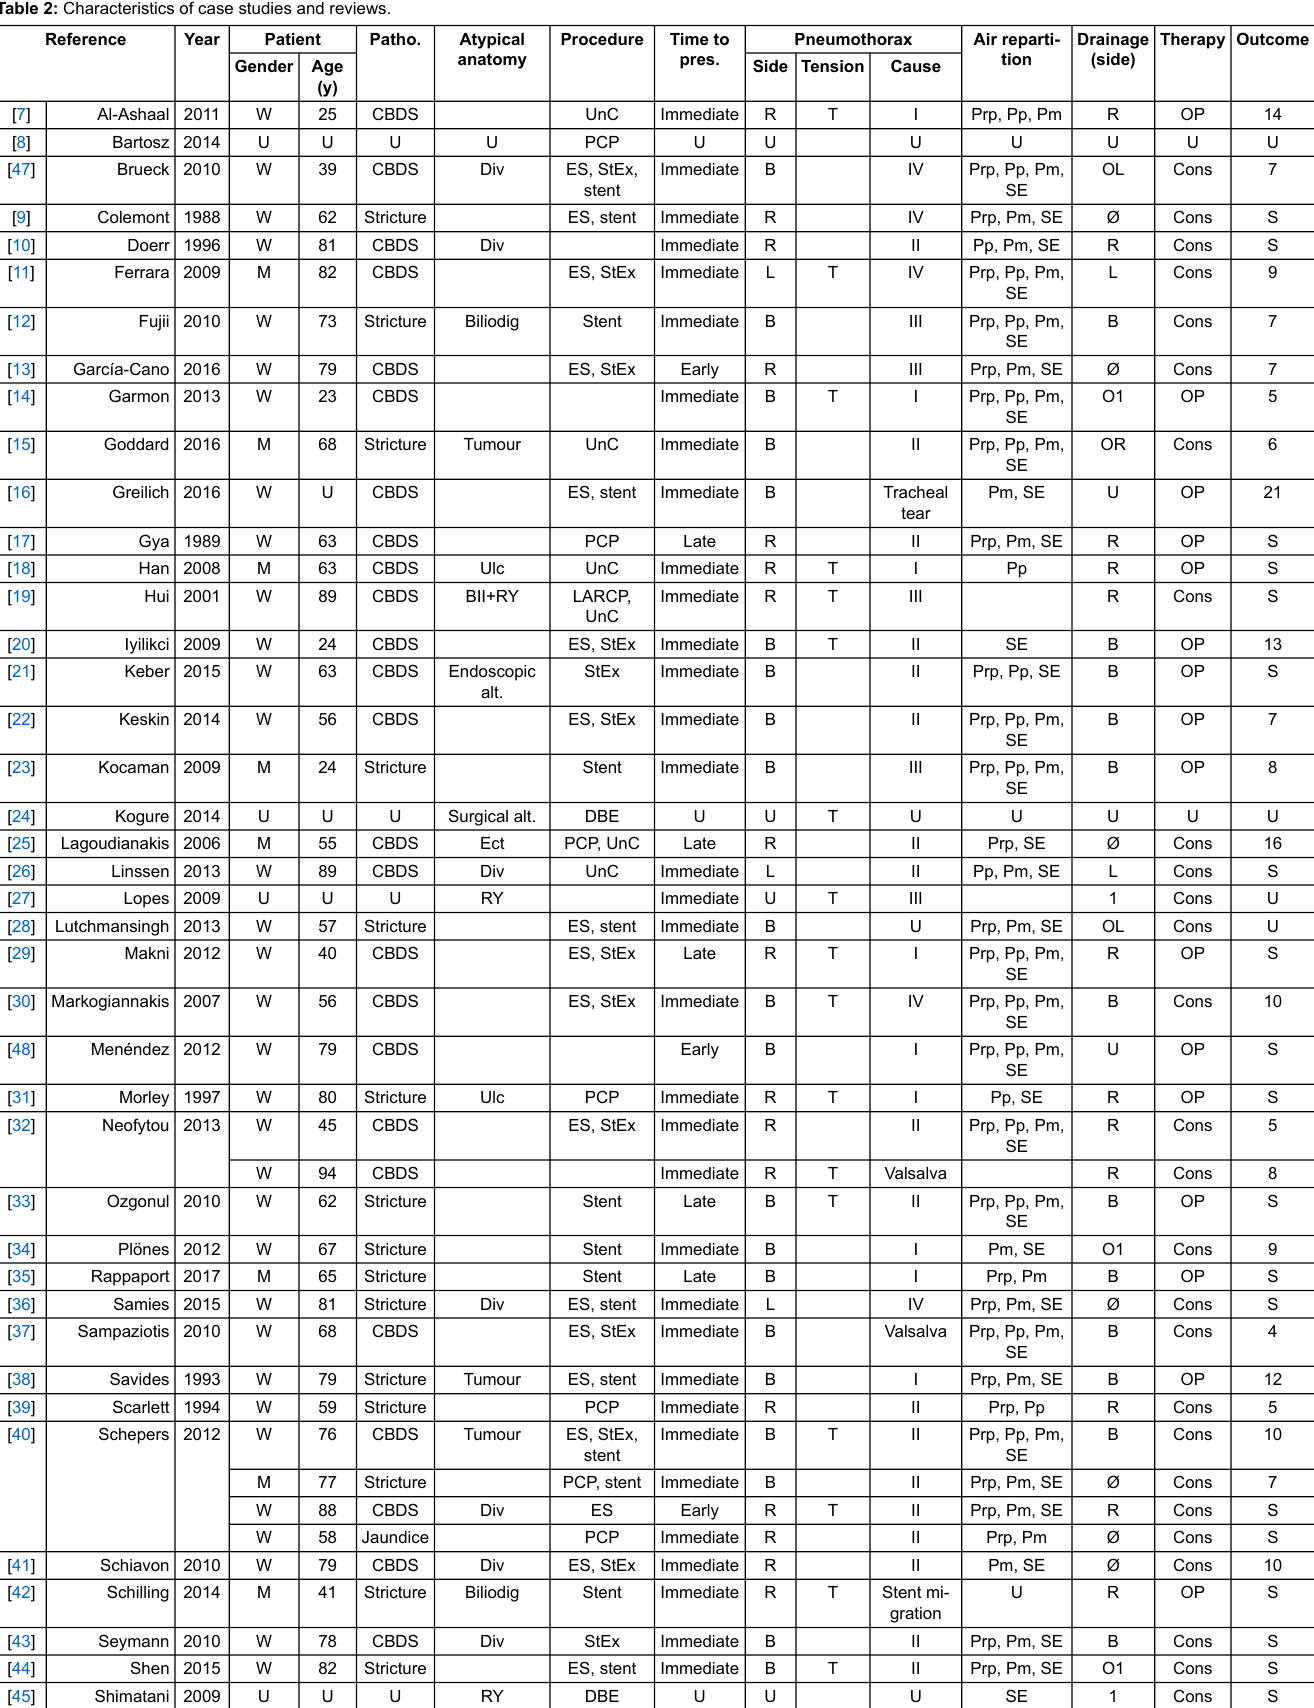
Table 2: Characteristics of case studies and reviews.